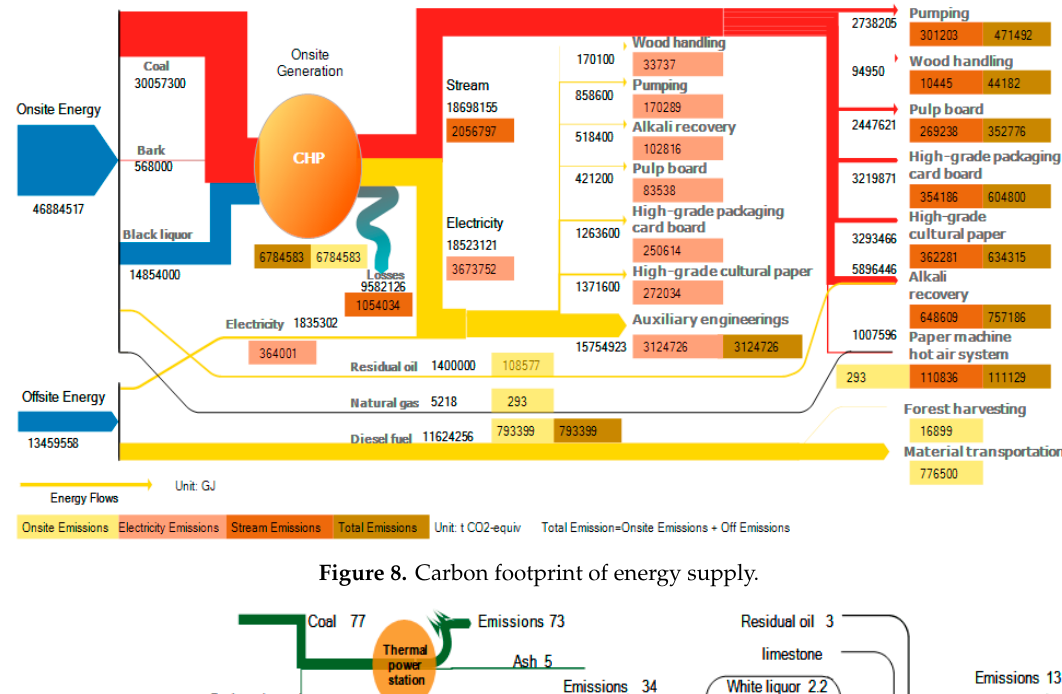
Figure 8. Carbon footprint of energy supply.